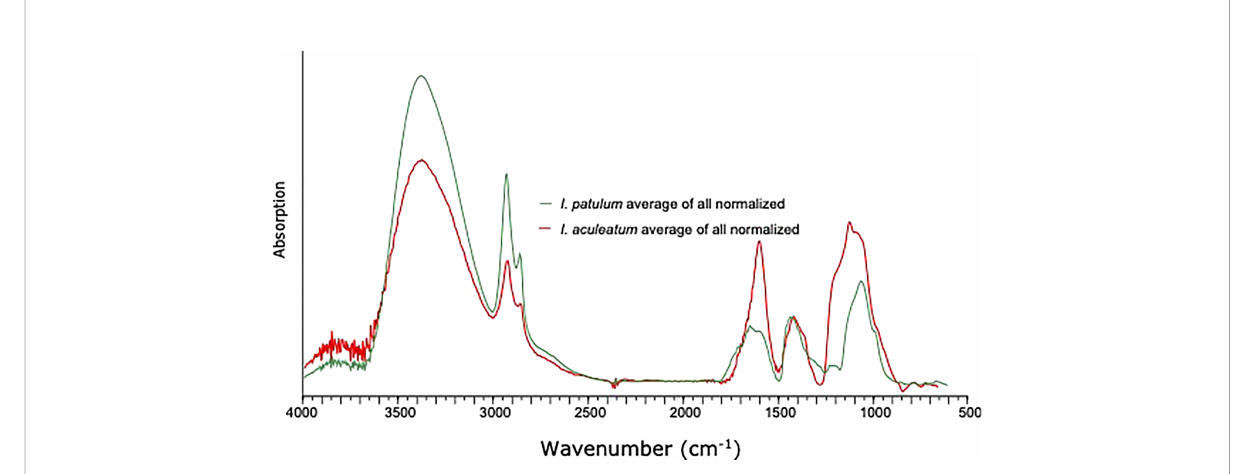
FIGURE 6 Comparison of compiled spectra of Impagidinium patulum and Impagidinium aculeatum